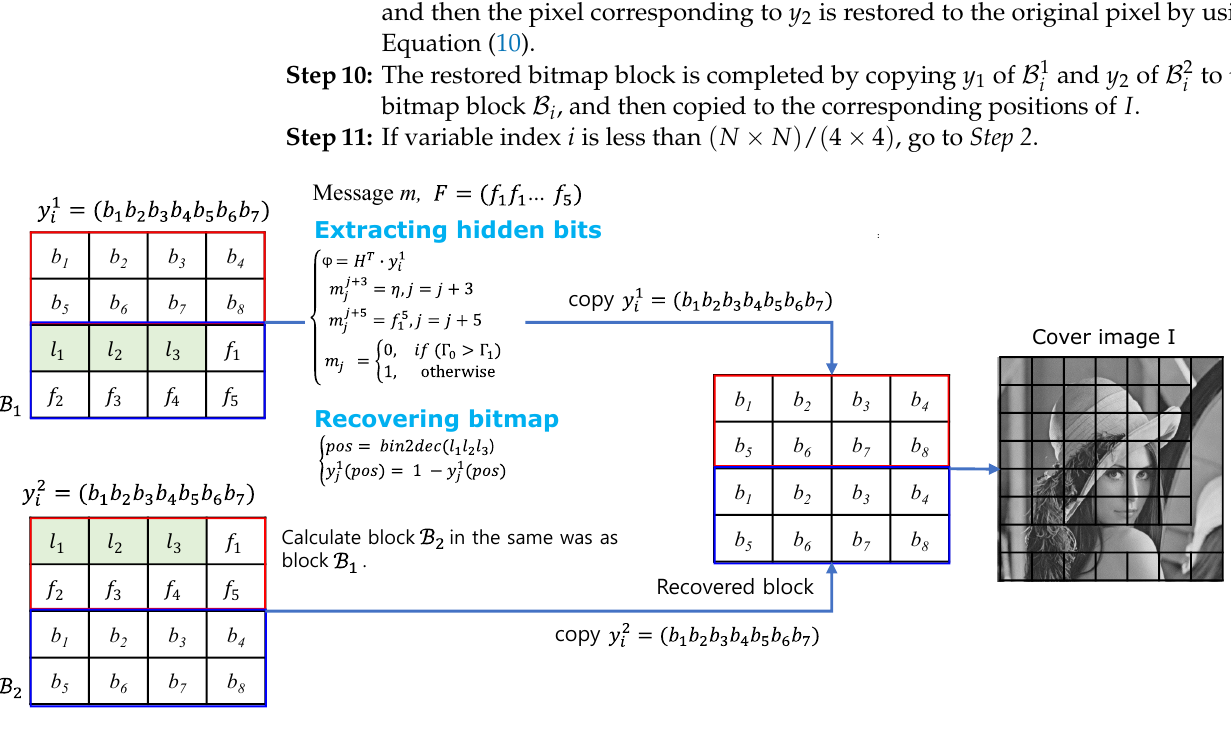
Figure 4. Diagram of extraction and recovering